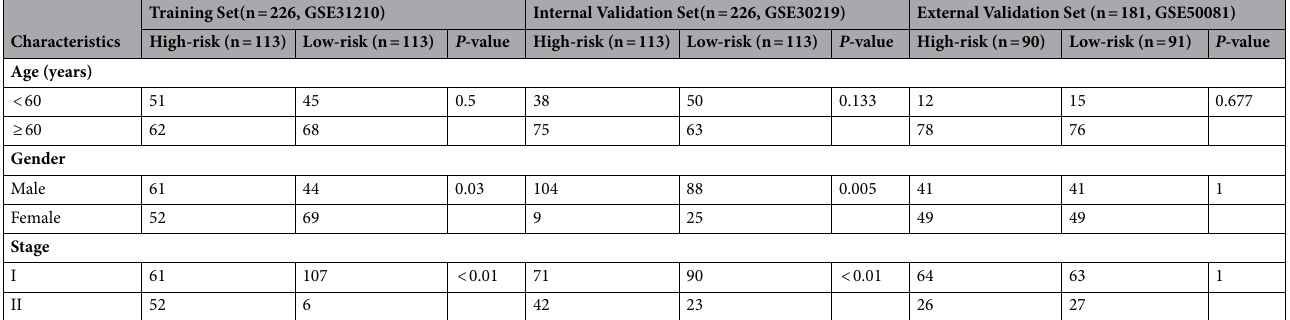
Table 2. Clinical characteristics of NSCLC patients on the basis of the fifteen-mRNA signature in the training (n = 226, GSE31210) internal validation (n = 226, GSE30219) and external validation (n = 181, GSE50081)